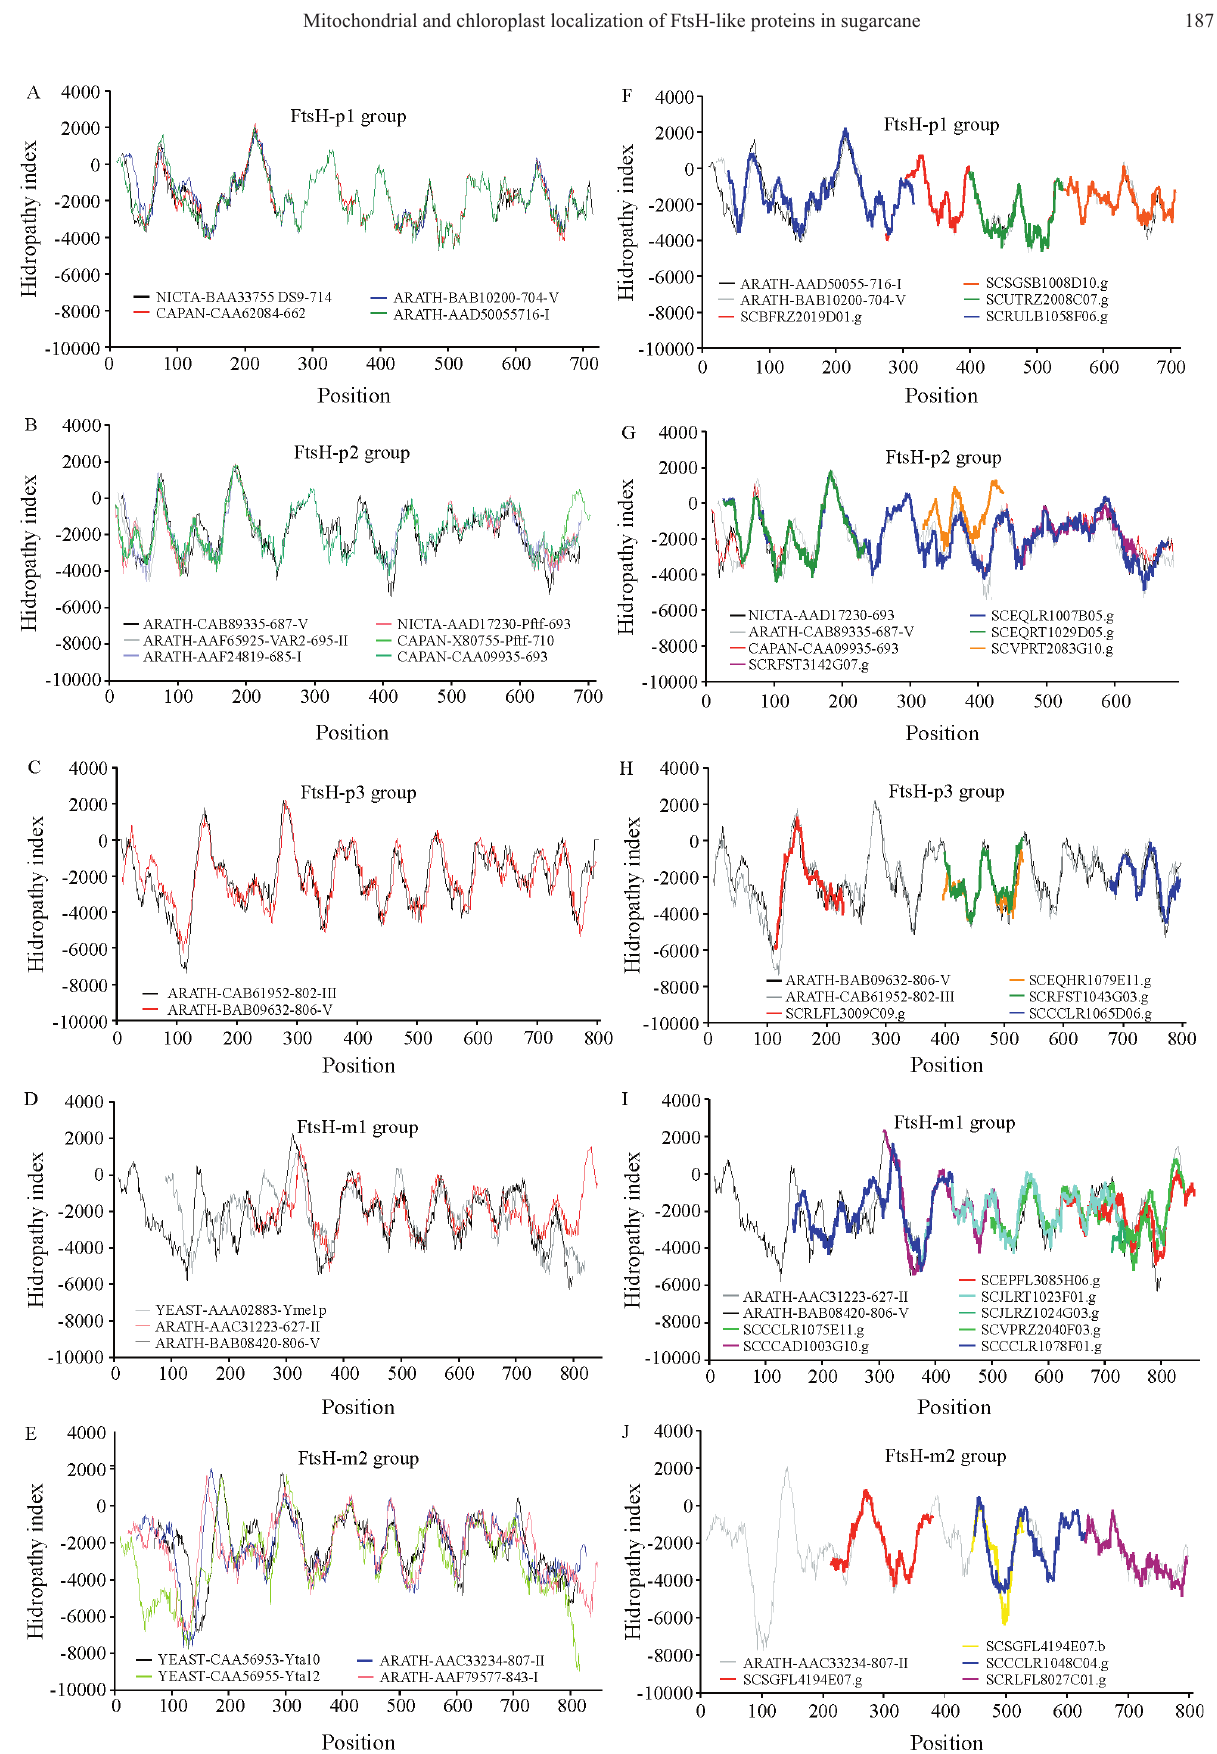
Figure 3 - Hidropathy index profile for sequences of the five plant phylogenetic groups (A, B, C, D and E) and for the aligned sugarcane EST clusters consensi (F, G, H, I and J). The EST clusters consensi were positioned in accordance to their best aligned protein sequence (see Table